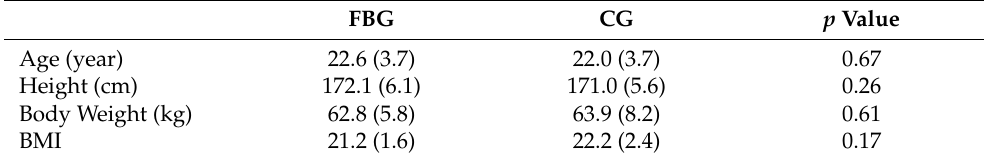
Table 1. Comparing baseline characteristics between groups. average (SD), p values < 0.05 are bolded.